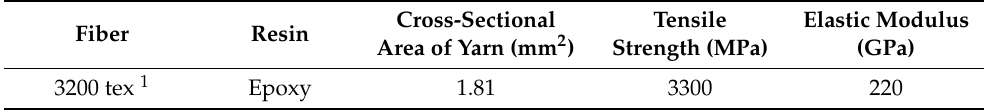
Table 1. Material properties of carbon textile grid (suggested by the manufacturer).